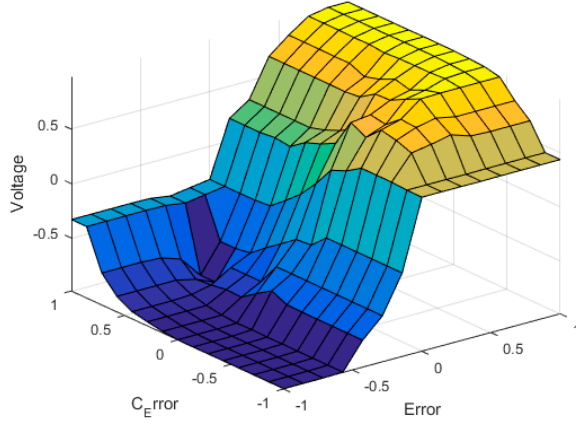
Figure 13. Surface of the best fuzzy system without considering noise.